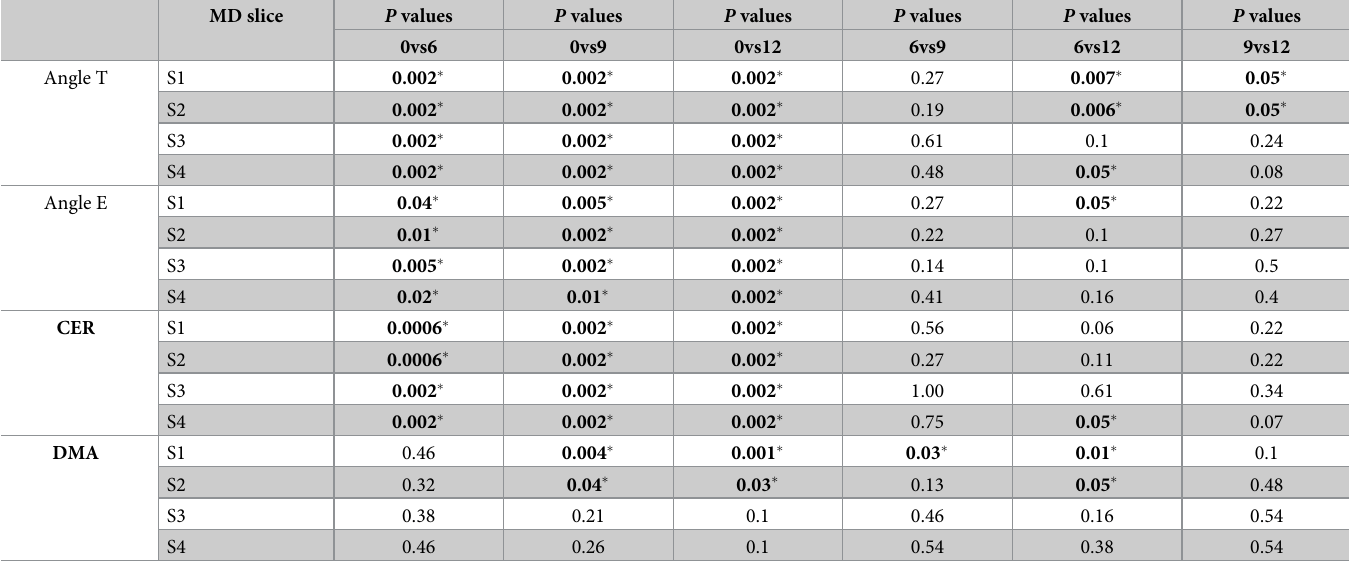
Table 5. Comparison of the different lateralization